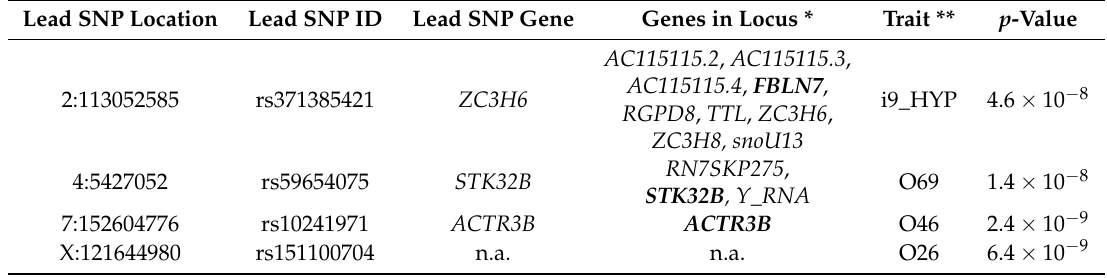
Table 1. Loci significantly associated with pregnancy-related traits in UK Biobank at p < 5 × 10 − 8 . Lead SNP Location Lead SNP ID Lead SNP Gene Genes in Locus * Trait ** p -Value